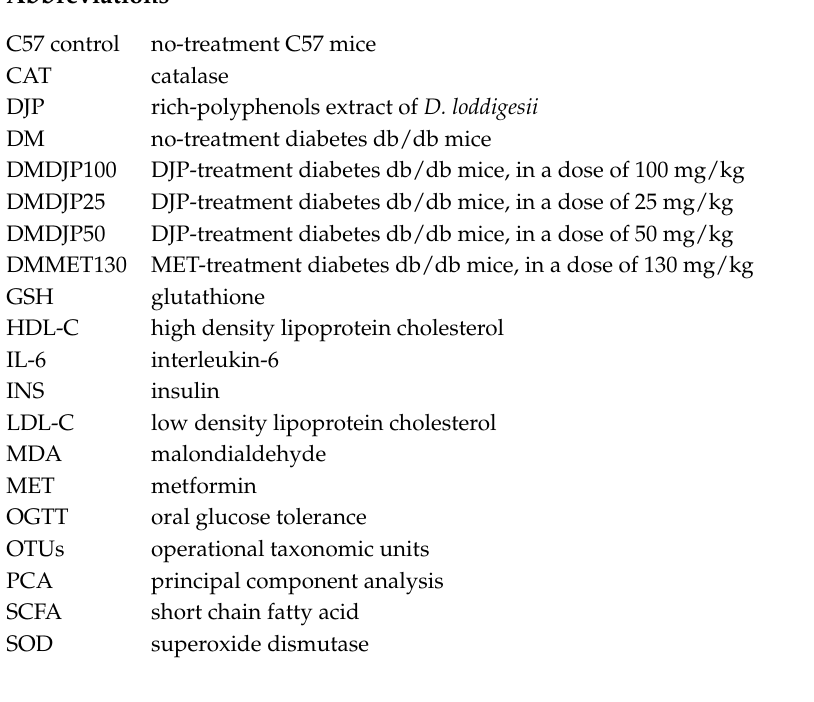
Table S1: Biological activities of rich-polyphenols extract of D. loddigesii (DJP) in vitro; Table S2: OTUs statistics detail, Table S3: DM-DMDJP100 differentially abundant